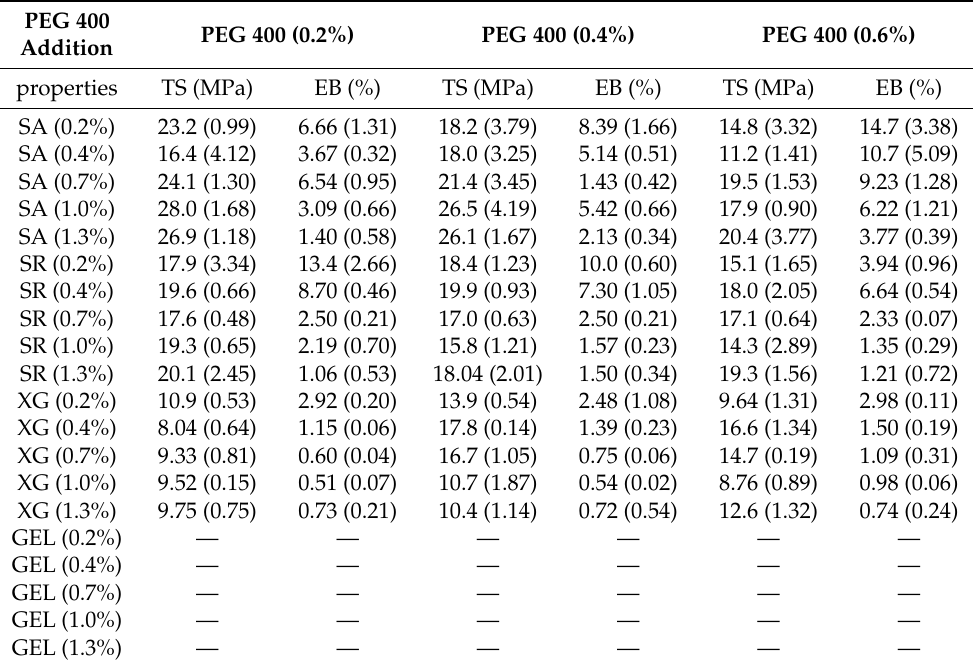
Table 3. The effect of PEG400 addition on the tensile strength (TS) and elongation at break (EB) of the composite films.